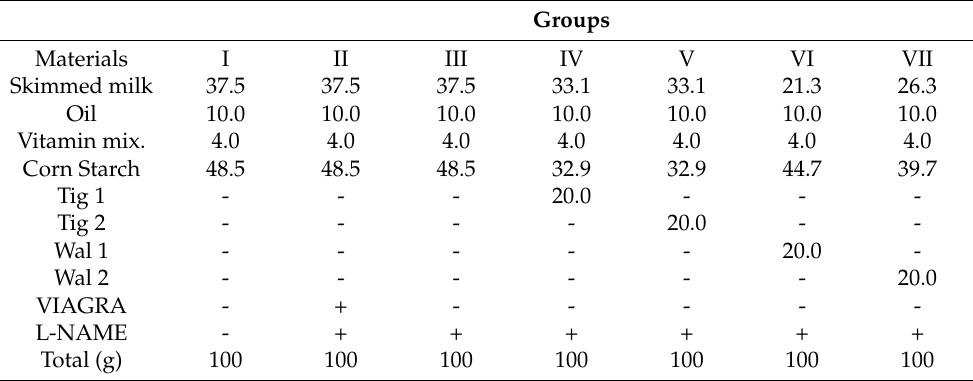
Table 1. Feed formulation chat for basal, tiger nut (TN) and walnut (WN) dietary supplementation for both control and test